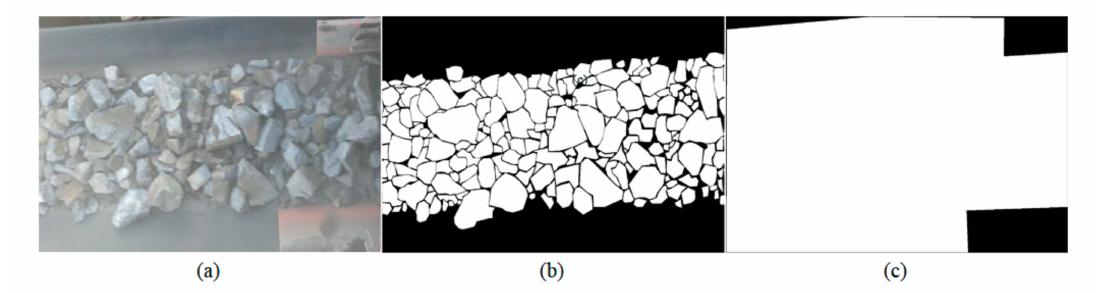
Figure 2. ( a ) Original images: ( b ) corresponding ground truth ( c ) field of view example.